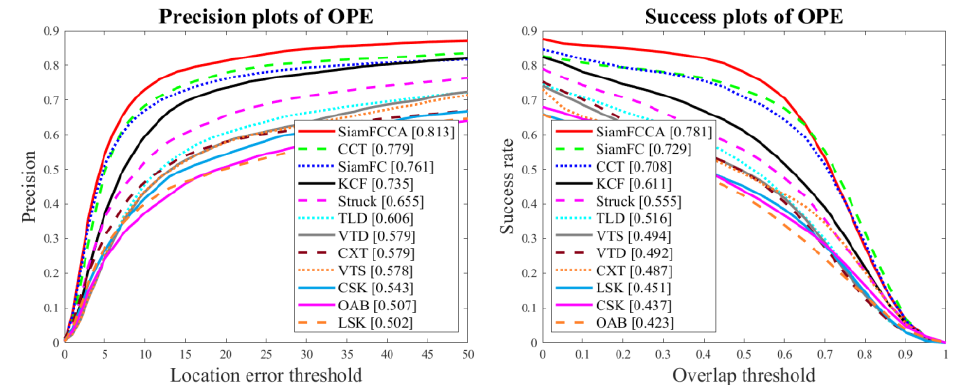
Figure 12. The precision and success plots of the proposed SiamFCCA and other tracking methods on all sequences.